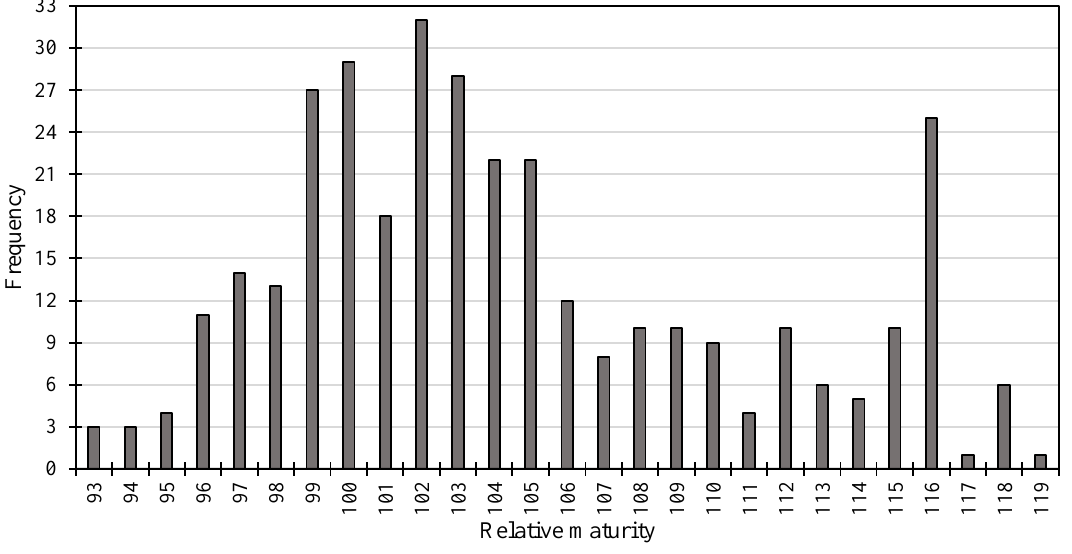
Figure 3. Maize maturity observations and their occurrence frequency for the 2003 – 2019 experiment Figure period.